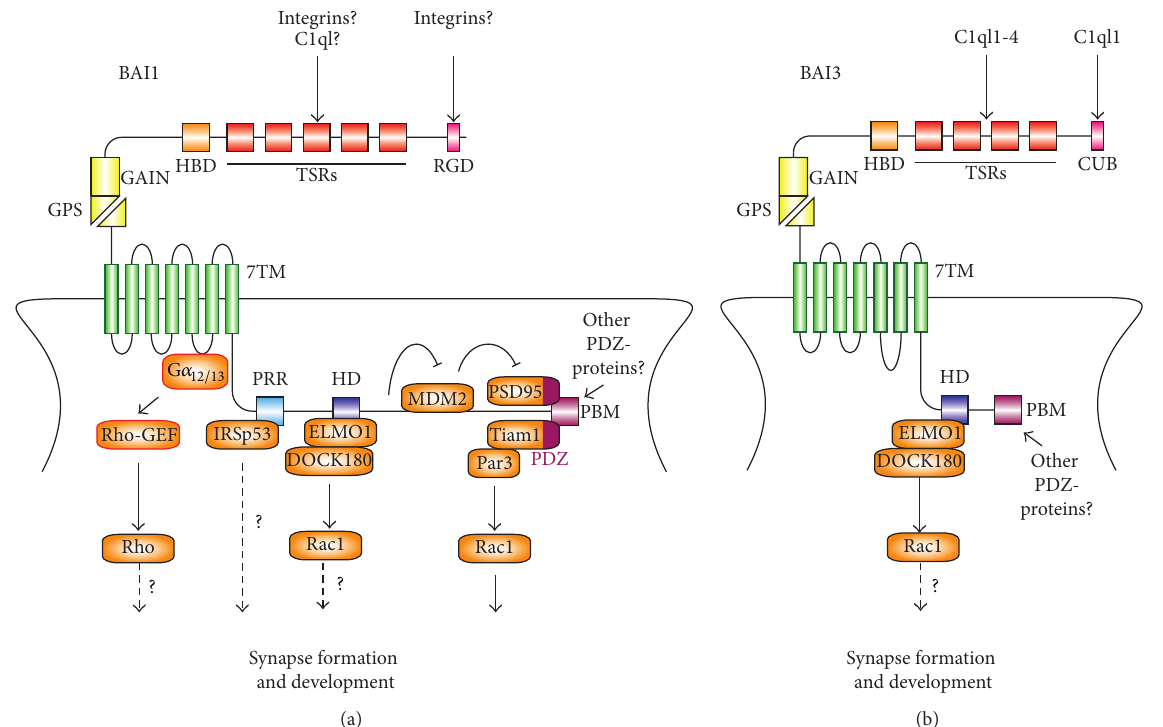
Figure 2: Synaptic binding partners and signaling pathways of BAI adhesion-GPCRs. (a) Synaptic interactions of BAI1. On the N-terminal segment of BAI1, the TSRs and the RGD motif are predicted to bind integrins. The TSRs also putatively bind complement C1ql factors, although the function of this interaction is unclear. BAI1 activates the RhoA pathway by coupling with G 𝛼 12/13 , although this has only been shown in cultured HEK293T cells and requires confirmation in neurons (red outline). The C-terminal region of BAI1 binds to IRSp53 via its proline-richregion(PRR),butthefunctionofthisinteractionneedstobefurtherexplored.BAI1alsointeractswiththeRac1activatormodules ELMO1/DOCK180 (via the 𝛼 -helical RKR motif (HD)) and Tiam1/Par3 (via the PDZ-binding motif (PBM)). However, only the Tiam1/Par3 interaction is required for BAI1’s effects on dendritic spine formation and excitatory synaptogenesis. In addition, BAI binds to the ubiquitin E3 ligase MDM2 and suppresses its polyubiquitination activity on PSD95, stabilizing PSD95 expression levels. (b) Synaptic interactions of BAI3. The TSRs and the CUB domain of BAI3 have been shown to bind complement C1ql factors C1ql3 and C1ql1, respectively. In cerebellar development, the C1ql1-BAI3 interaction helps establish proper synaptic connectivity in Purkinje cells and maintain a single-winner climbing fiber. The 𝛼 -helical RKR motif (HD) of BAI3 also interacts with ELMO1/DOCK180 to regulate dendritogenesis, but the role of this interaction in synaptogenesis remains to be